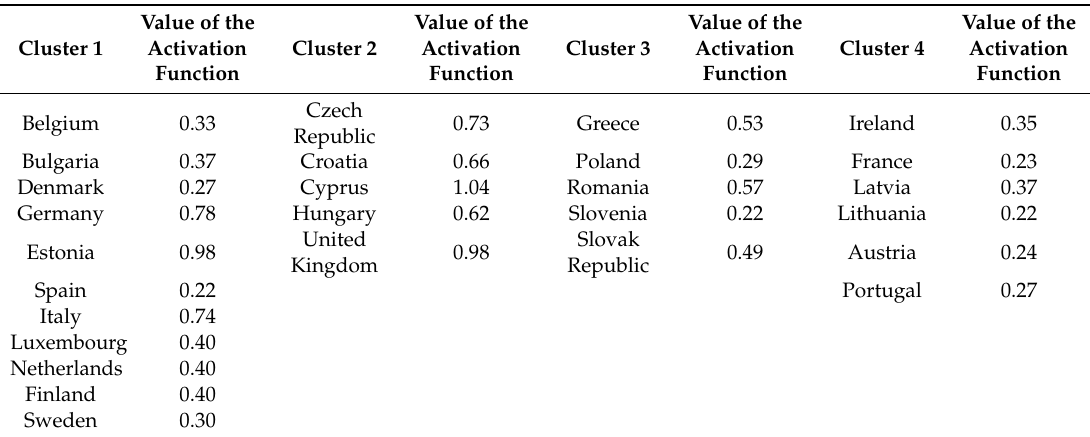
Table 9. Division of the EU countries into similar groups by the total value of emissions of harmful substances together with the values of the activation function (own